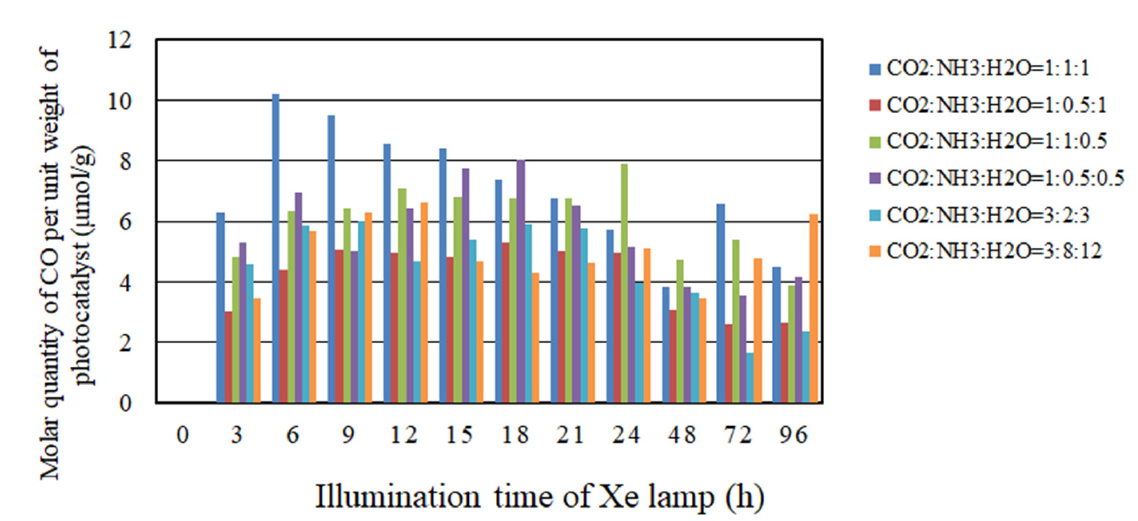
Figure 2. Comparison of molar quantity of CO per unit weight of photocatalyst under the illumination condition of Xe lamp with UV light. The pulse number is 100. The highest CO 2 reduction characteristic is obtained under the condition of the molar ratio of CO 2 /NH 3 /H 2 O = 1:1:1 where the molar quantity of CO per unit weight of photocatalyst is 10.2 mol/g.